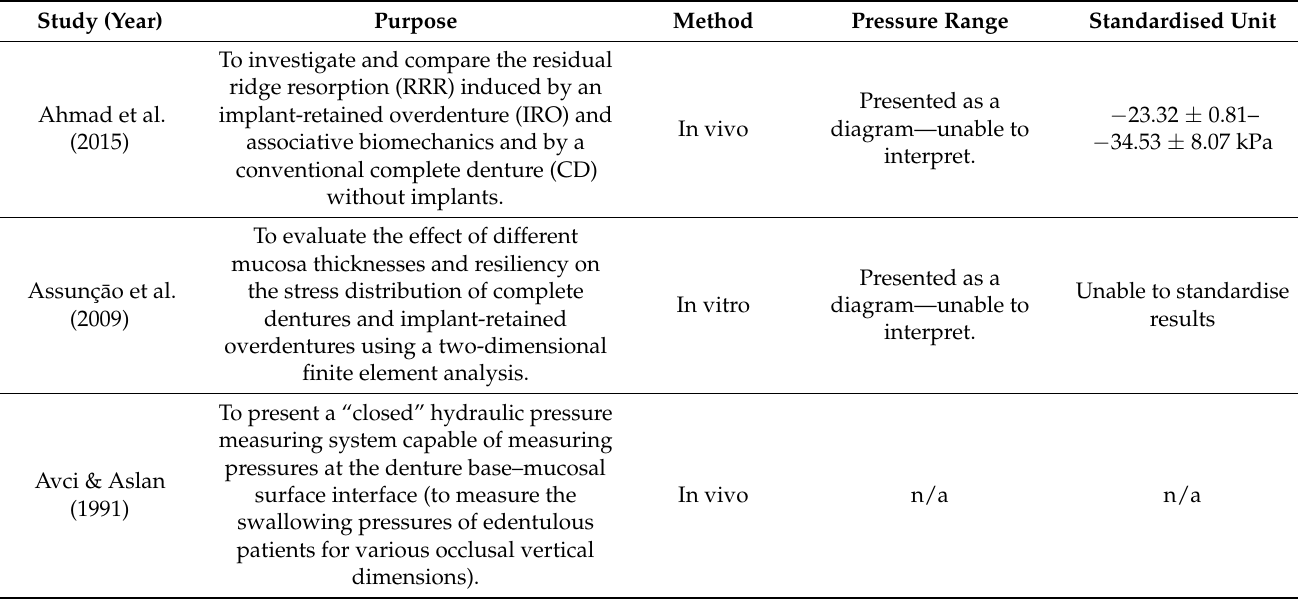
Table 3. Summary of full-text literature